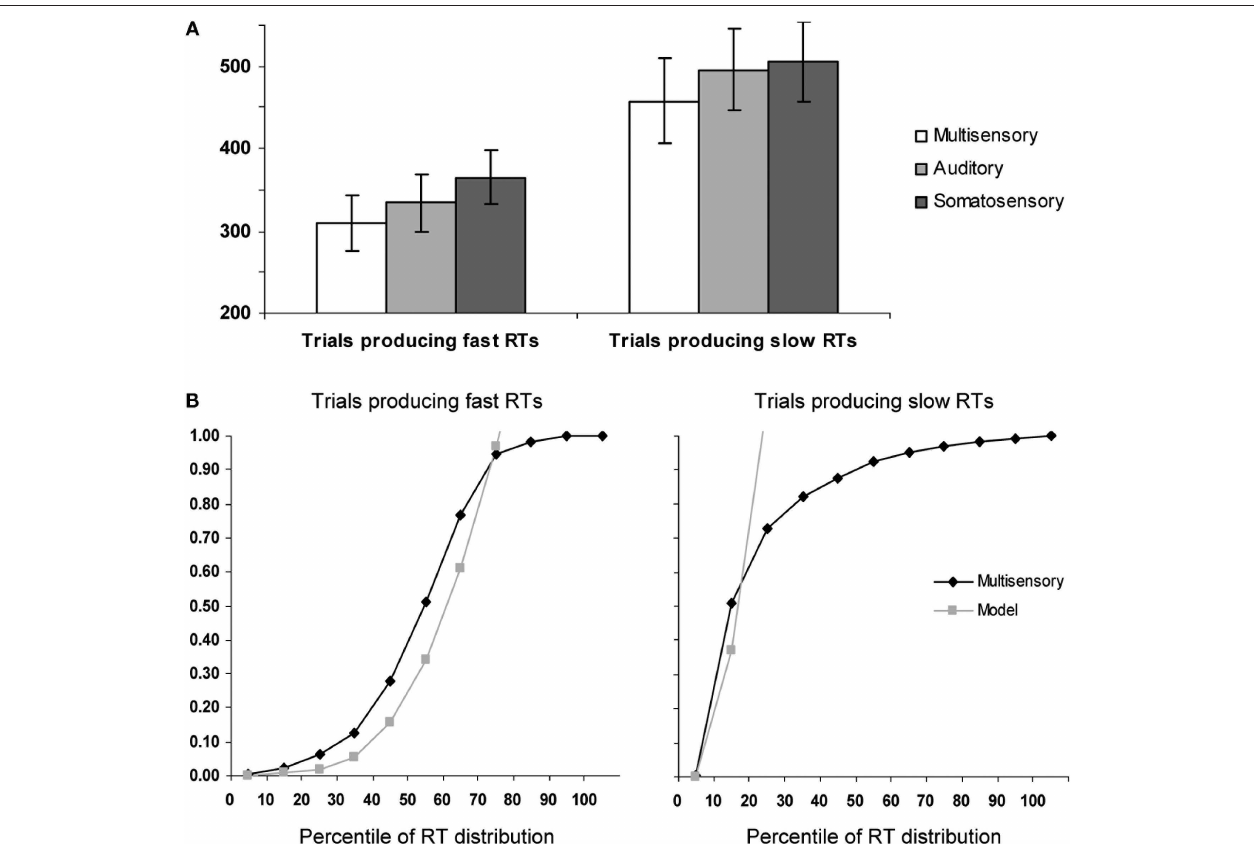
probability distributions of the reaction time data. The model is the arithmetic sum of the cumulative probabilities from auditory and somatosensory trials. The x -axis indicates the percentile of the reaction time distribution after median split of the data. As above, the left and right panels show data from trials producing faster and slower RTs,